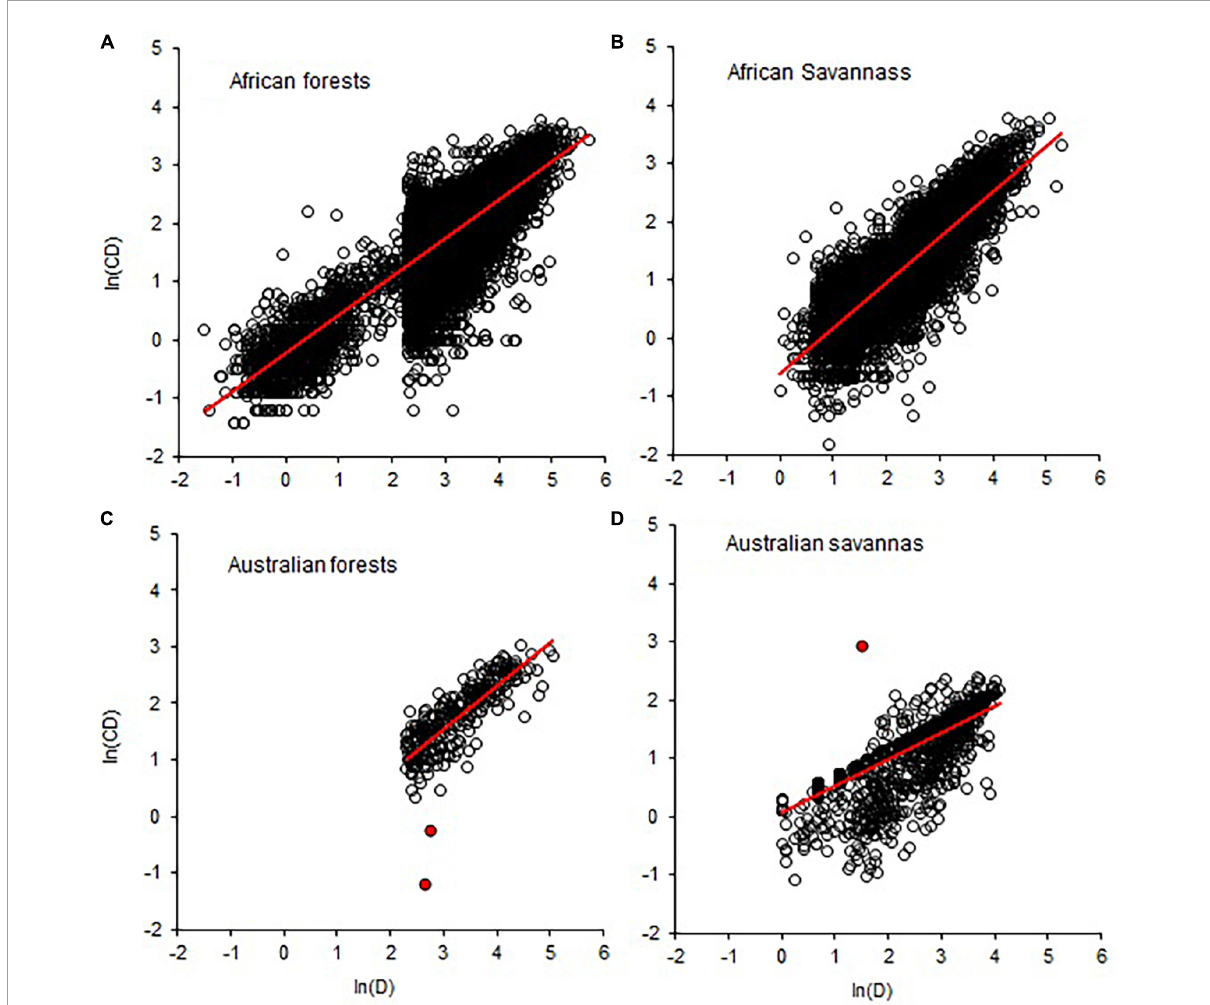
FIGURE4 Comparison of forest and savanna biomes in terms of data quality in the allometric scaling of crown diameter with stem diameter (CD–D). Breaks in the distribution of values in A and B indicate the bias in sampling towards D > 5 (B) and D > 10 (A) and data truncation. Red circles in (C,D) are indicative of measurement errors. The red lines are OLS fitted